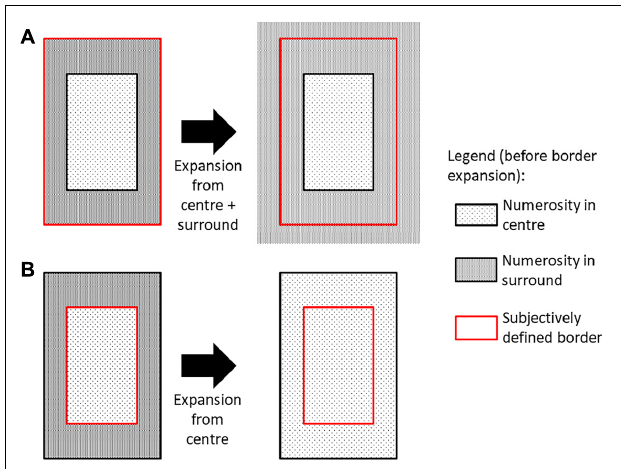
FIGURE 5 | One plausible explanation for border expansion responses when participants were asked to judge the number of dots in the surrounding portion of the display. Here bistable perception is assumed to depend on whether the subjectively defined border which is expanded includes both central and surround areas, which doesn’t affect numerosity perception in surround (A) , or only the central area, which would then be expanded into the surround (B)